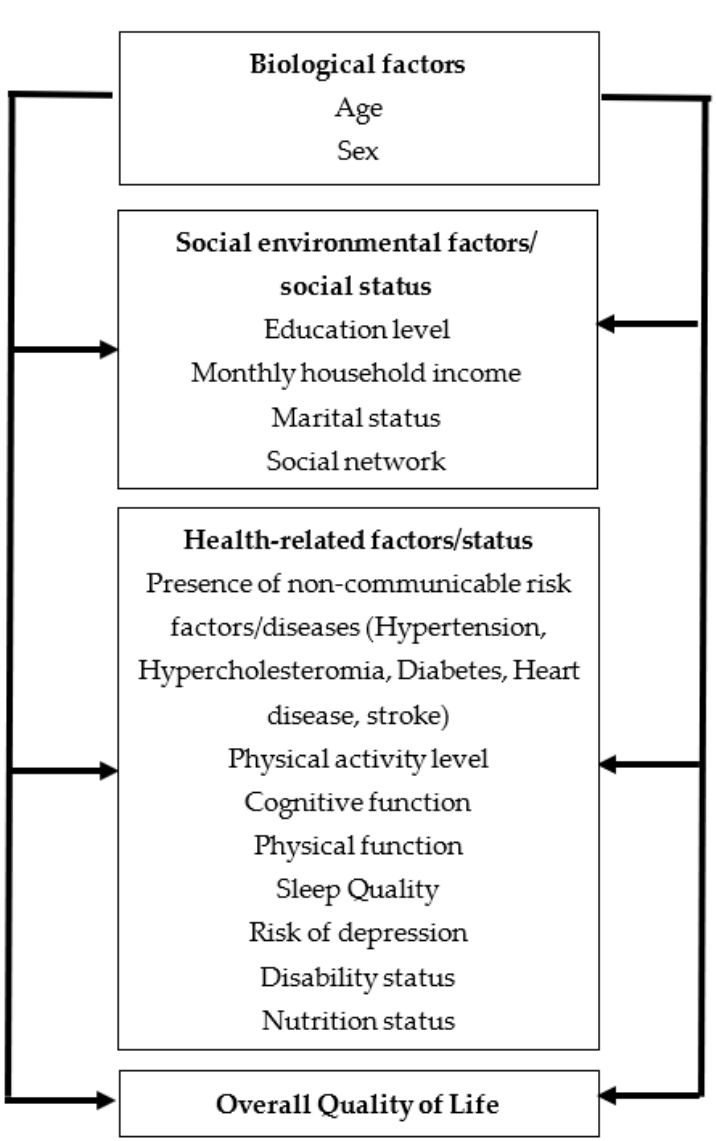
Figure 1. Conceptual framework adapted based on the revised Wilson – Cleary model of HRQoL.